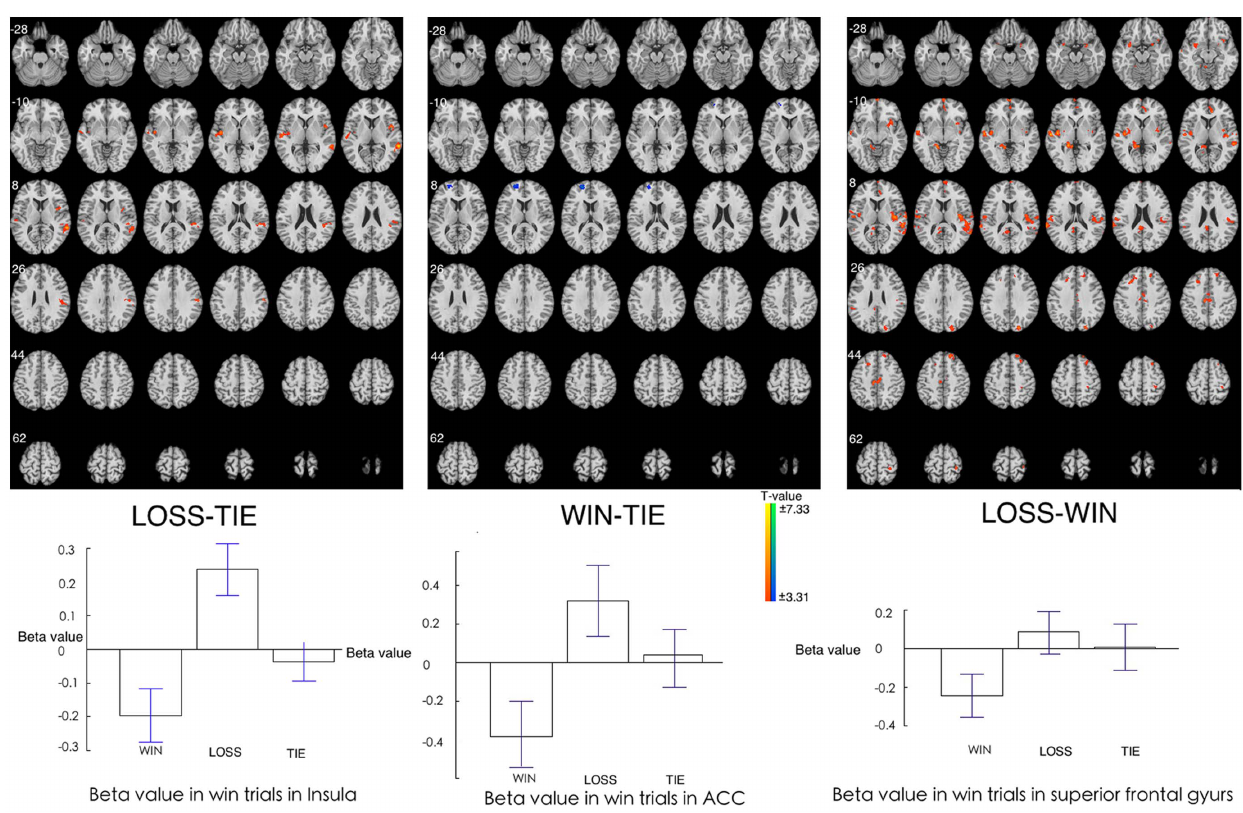
Figure 4. Brain areas showing different activations after win trials among WIN, LOSS, and TIE situations. Upper : Higher activation is found in posterior cingulate cortex in LOSS to TIE condition. No difference was found in other comparisons. Bottom : Beta figures in PCC in win trials in different situations.